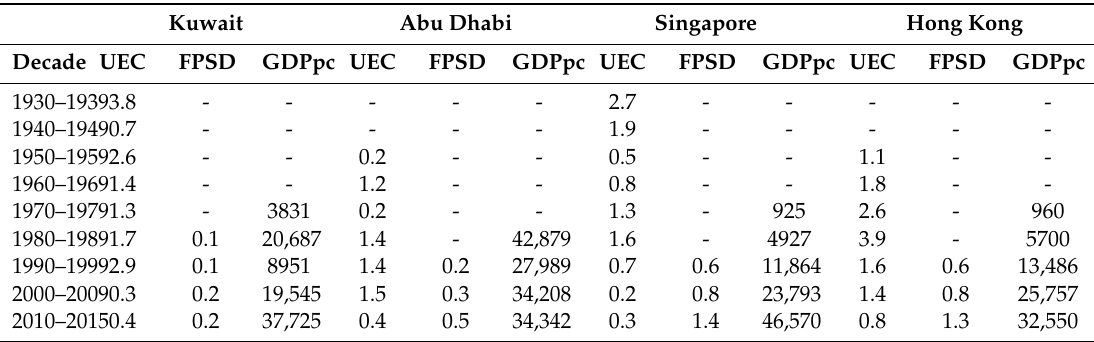
Table 3. UEC plus key price indicators 8